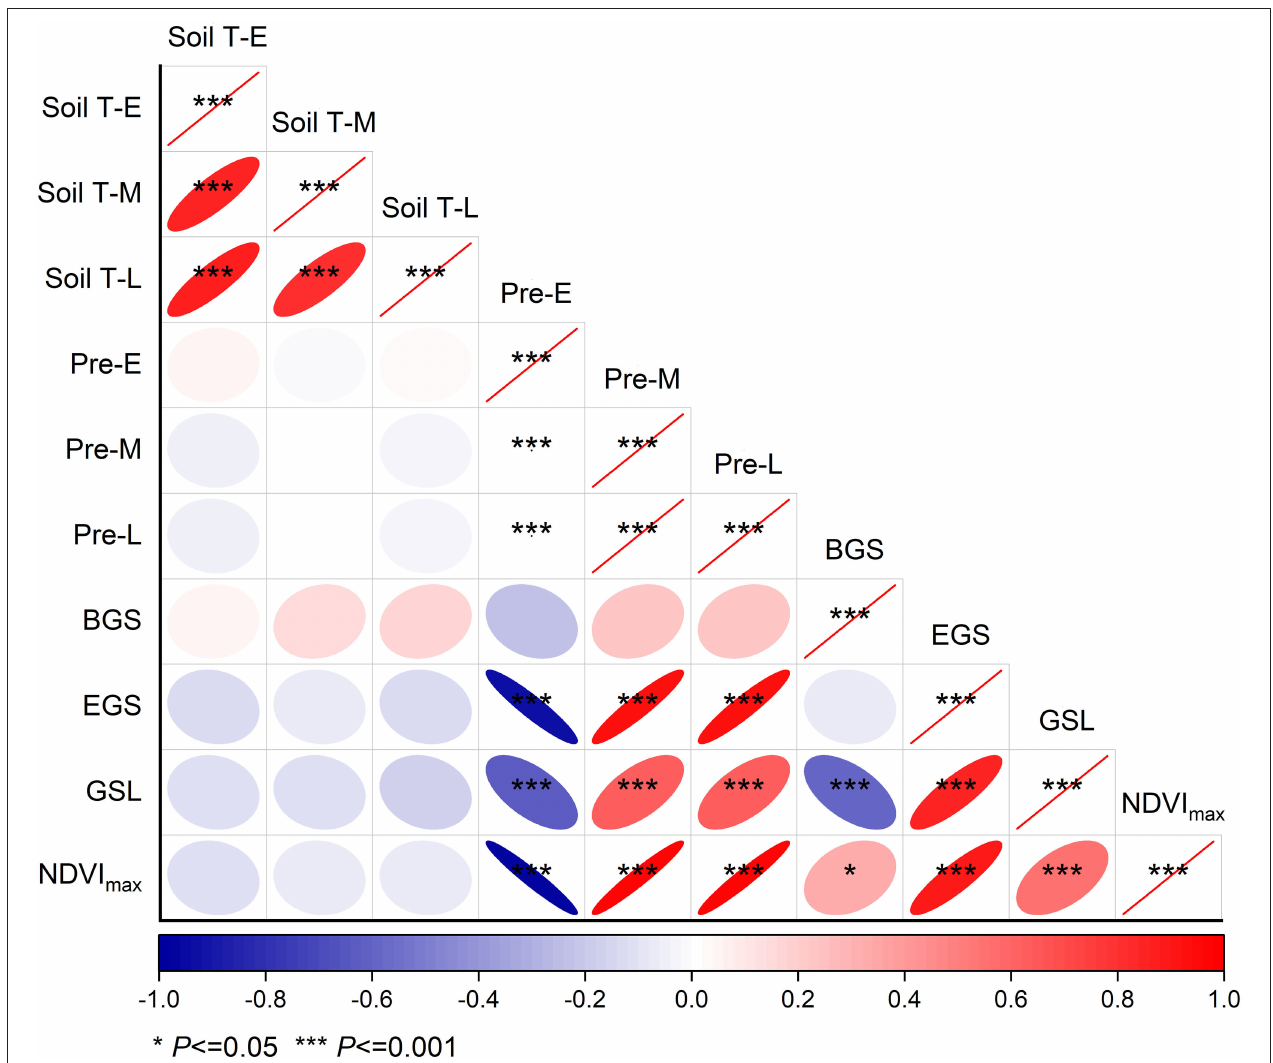
FIGURE 3 | Relationships of beginning, ending, and length of growing season, as well as the maximum of normalized difference vegetation index with soil temperature and precipitation in the early (E, May–June), middle (M, July–August), and late (L, September–October) of growing season, respectively, over 2 years from 2014 to 2015. Refer to abbreviations in Table 1